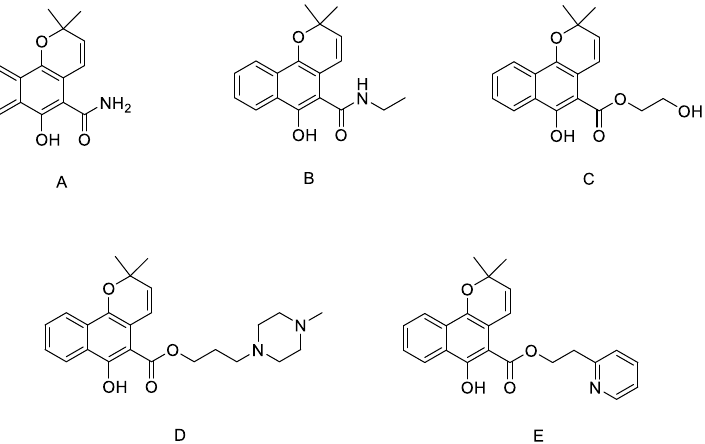
Figure 1. Previously reported mollugin derivatives as anti-inflammatory agents. ( A ) Lead compound A ; ( B ) Lead compound B ; ( C ) Lead compound C ; ( D ) Lead compound D ; ( E ) Lead compound E .